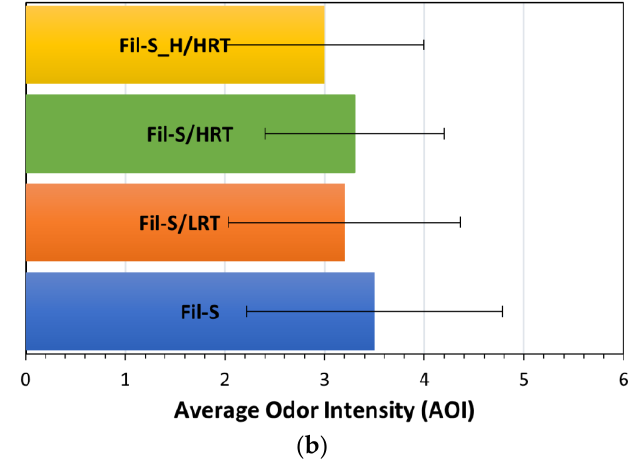
Figure 5. Panel tests’ results on: ( a ) PW and ( b ) Fil-S samples subjected to different degassing conditions.